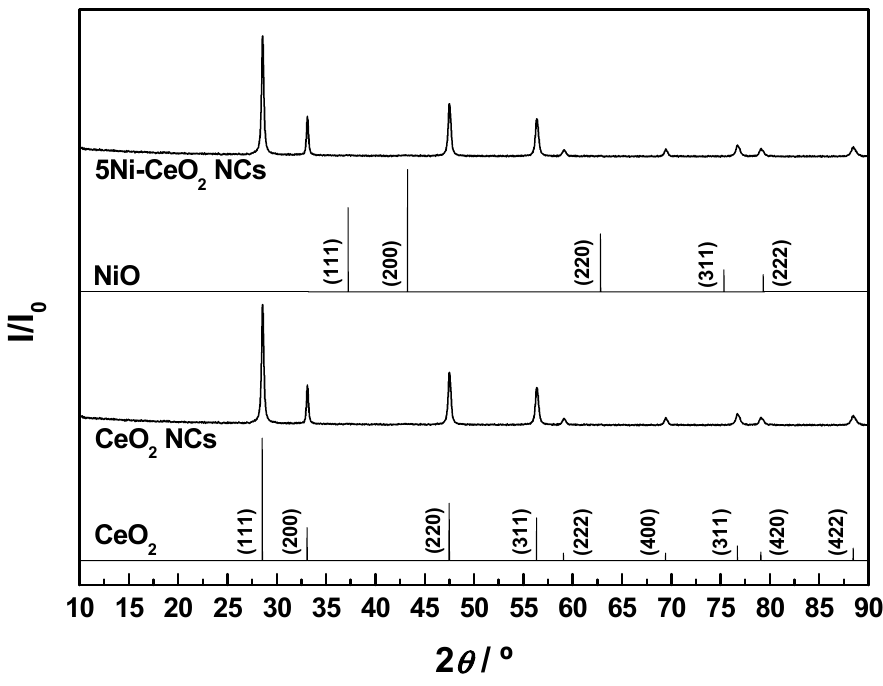
Figure 1. X-ray diffraction (XRD) diagrams recorded for the freshly prepared CeO 2 nanostructured catalysts (NCs) and 5Ni-CeO 2 NCs samples. Reference patterns for cubic fluorite-type CeO 2 and face-centered cubic NiO are also plotted for comparison purposes.